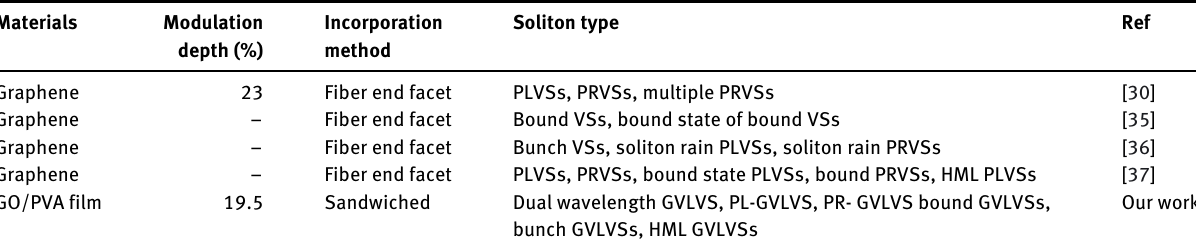
Figure 8: HML GVLVSs of EDFL based on GO/PVA film. (a) Time trace (FML: purple line, 2nd HML: green line, 3rd HML: brown line and 7th HML: navy line.), (b) output power of GVLVSs as a function of pump power in operation in different harmonic states, (c) optical spectrum of the 7th HML GVLVSs and zoomed in spectrum of the Kelly sidebands (inset figure). Table 1: Vector solitons in Er-doped fiber laser based on 2D material